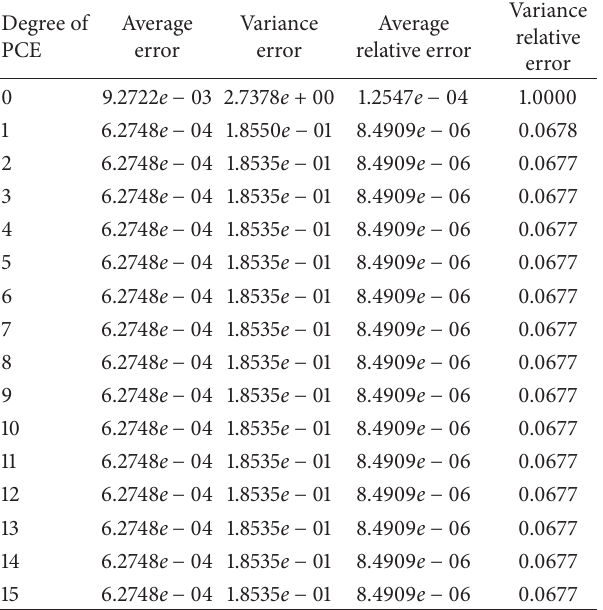
Table 10: Error of the average and variance of the PCE approx- imation of the CIR interest rate model with higher precision in computing {𝑅 𝑇,𝑗 } 𝑁 𝑗=1 and parameters 𝛼 = 0.1 , 𝛽 = 0.2 , and 𝜎 = 0.15